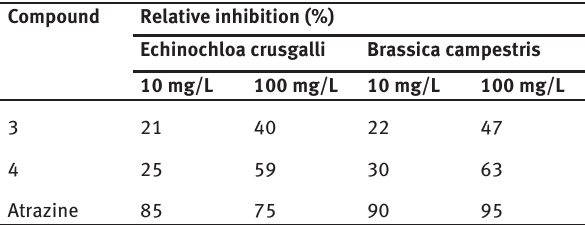
Table 2: Herbicidal activity (%) of steroids (3 and 4) against seedling growth of two weeds.